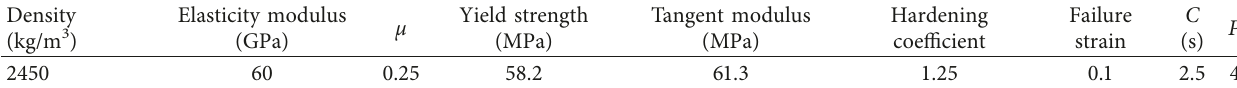
Table 2: Rock mechanical parameters.